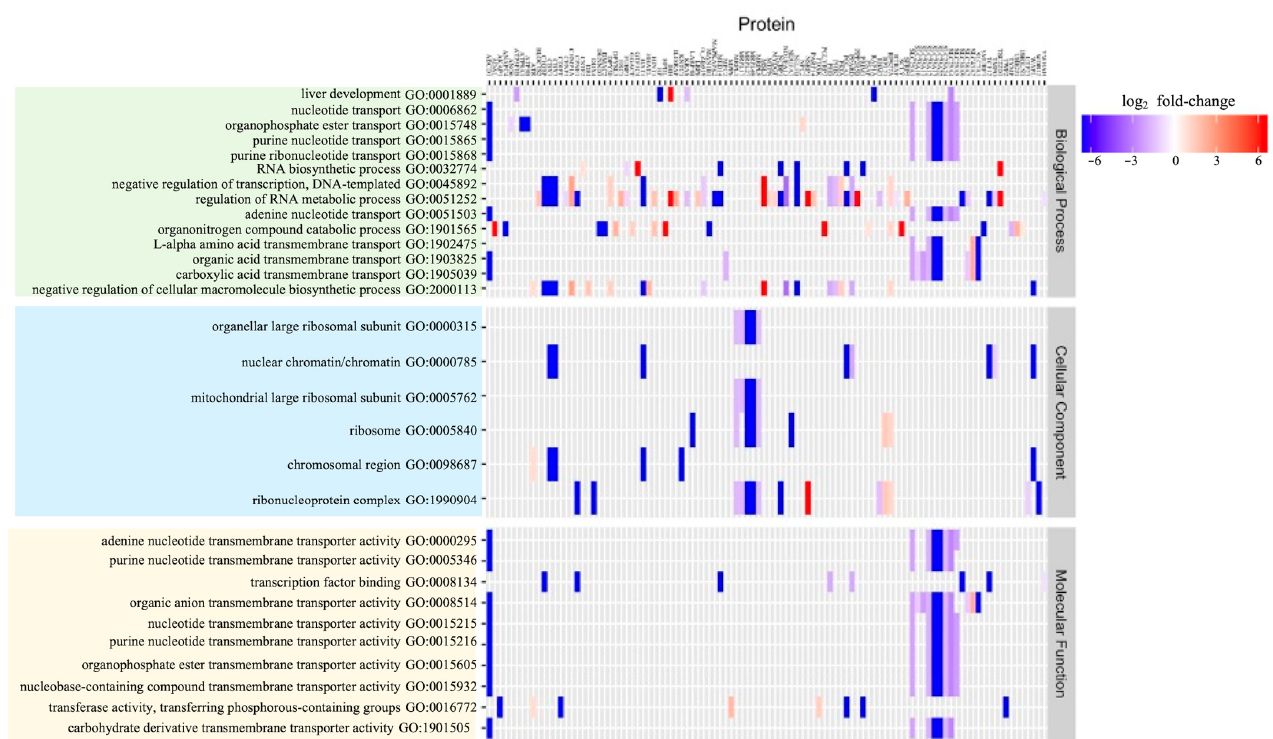
Figure 4. GSEA of the A β 42 proteome highlights the contribution of mitochondrial pathways. A heatmap of GSEA within primary GO domains shows 30 enriched pathways within the A β 42 proteome. The extent of protein abundance shift within A β 42 treated cells ( vs . control) is indicated. Table 1. GSEA identified GO pathways enriched with the A β 42 proteome data set GO ID #